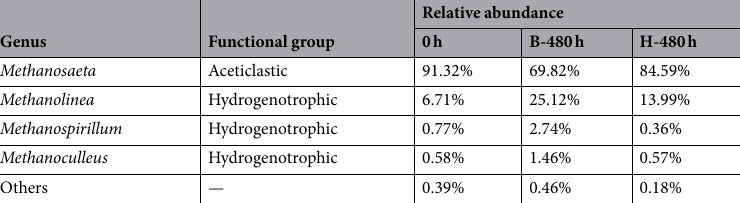
Table 2. Taxonomic composition of archaeal community at genus level of blank and H groups.